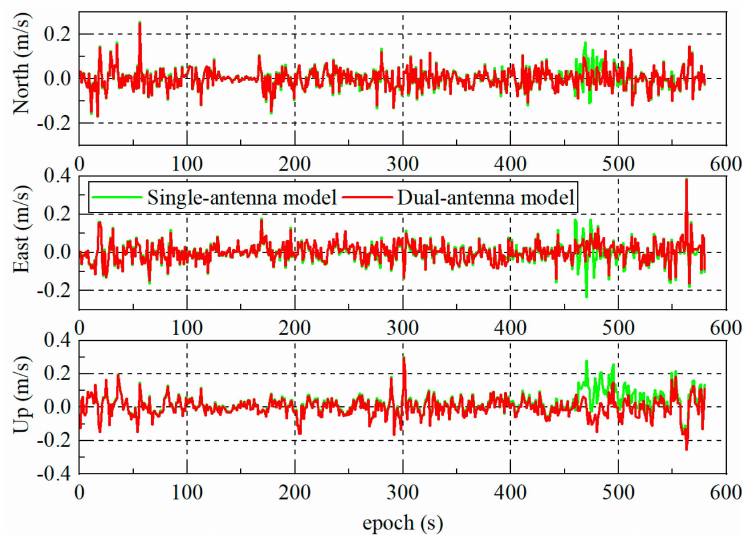
Figure 6. Velocity error of dual-system (GPS + BDS) GNSS/MIMU tightly coupled integration using the EKF in single-antenna mode and dual-antenna mode.